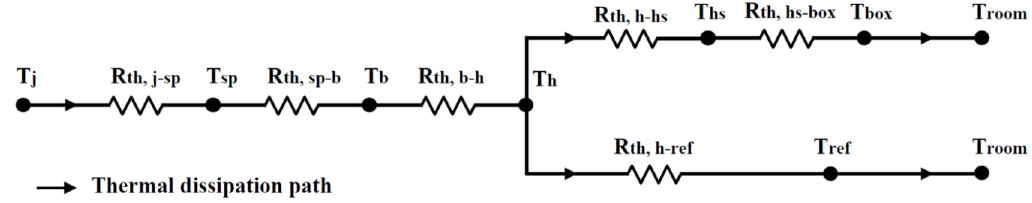
Figure 2. Illustration of thermal resistance network for the CLRDL after INST.